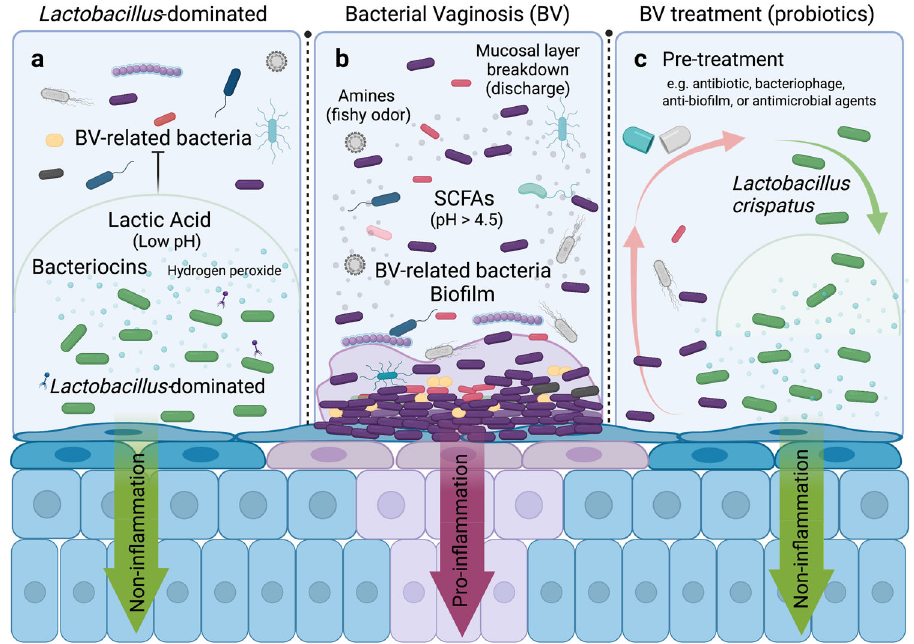
Fig. 1 Overview of the strategy on vaginosis treatment with probiotics. a Lactobacillus -dominated vaginal microbiome environment. Vaginal Lactobacillus species, such as Lactobacillus crispatus , produce lactic acid, bacteriocins, and hydrogen peroxide (H 2 O 2 ), which may provide protection against bacterial vaginosis (BV) related bacteria and other infections. b BV microbiome environment. BV-related bacteria (mainly Gardnerella ) induce in fl ammation in the vaginal tract and form a bio fi lm on vaginal epithelial cells. The latter probably increases antibiotic resistance and refractoriness to probiotic treatment. Short chain fatty acids (SCFAs) produced by BV-related bacteria, increase vaginal pH. In addition, catabolism of amino acids and mucosal proteins results in amines and a thinner mucosal layer in the vaginal tract. c Treatment of BV with probiotics. Pretreatment such as antibiotic, bacteriophage, anti-bio fi lm, or antimicrobial agents, in combination with vaginal probiotic species and vaginal administration, increase the probability of successful colonization. Note: fi gure was created with